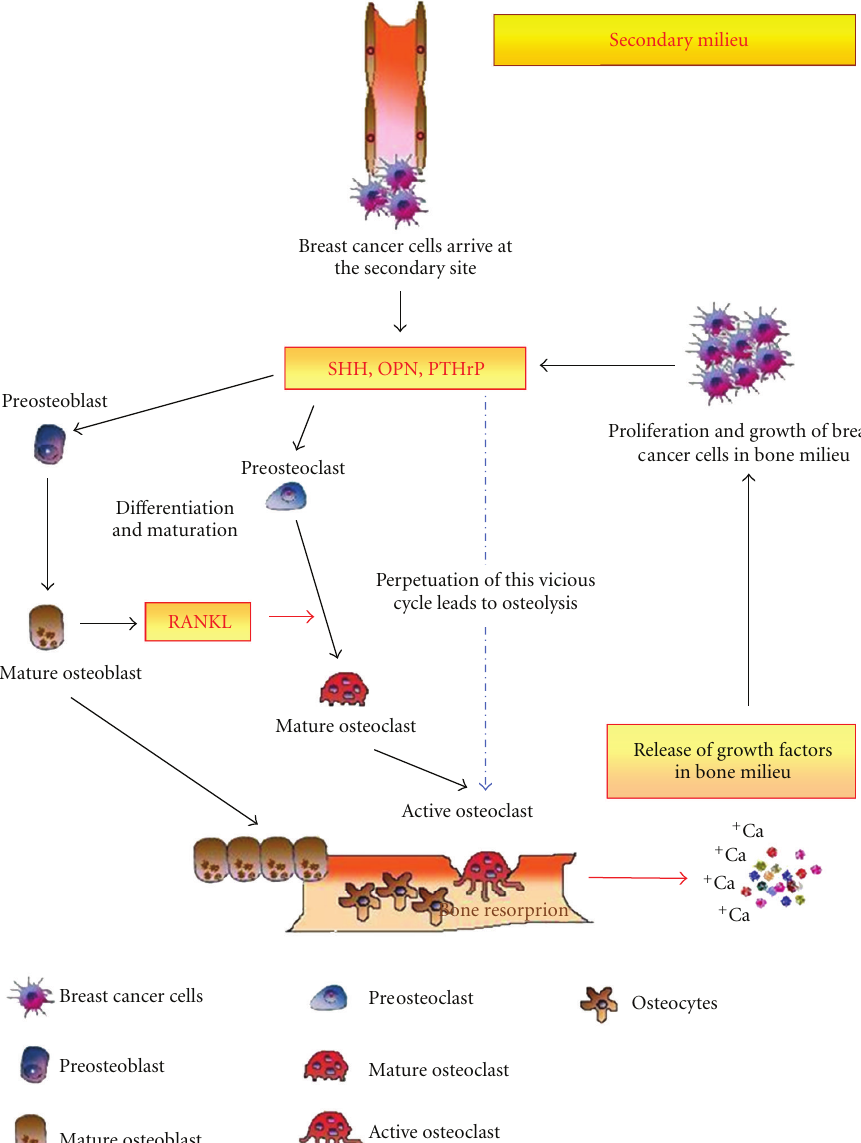
Figure 2: Breast cancer cells armed with Hh signaling disrupt the dynamic equilibrium in the bone to serve its purpose of self propagation and subsequent osteolysis. Breast cancer cells engane in a crosstalk with osteoblasts and osteoclasts. This cumulatively results in the di ff erentiation and activation of osteoclasts and eventually leads to enhancing osteolysis and growth of breast tumor cells in the bone. Overall, this figure addresses the role of Hh signaling in the vicious cycle of osteolytic metastasis of breast